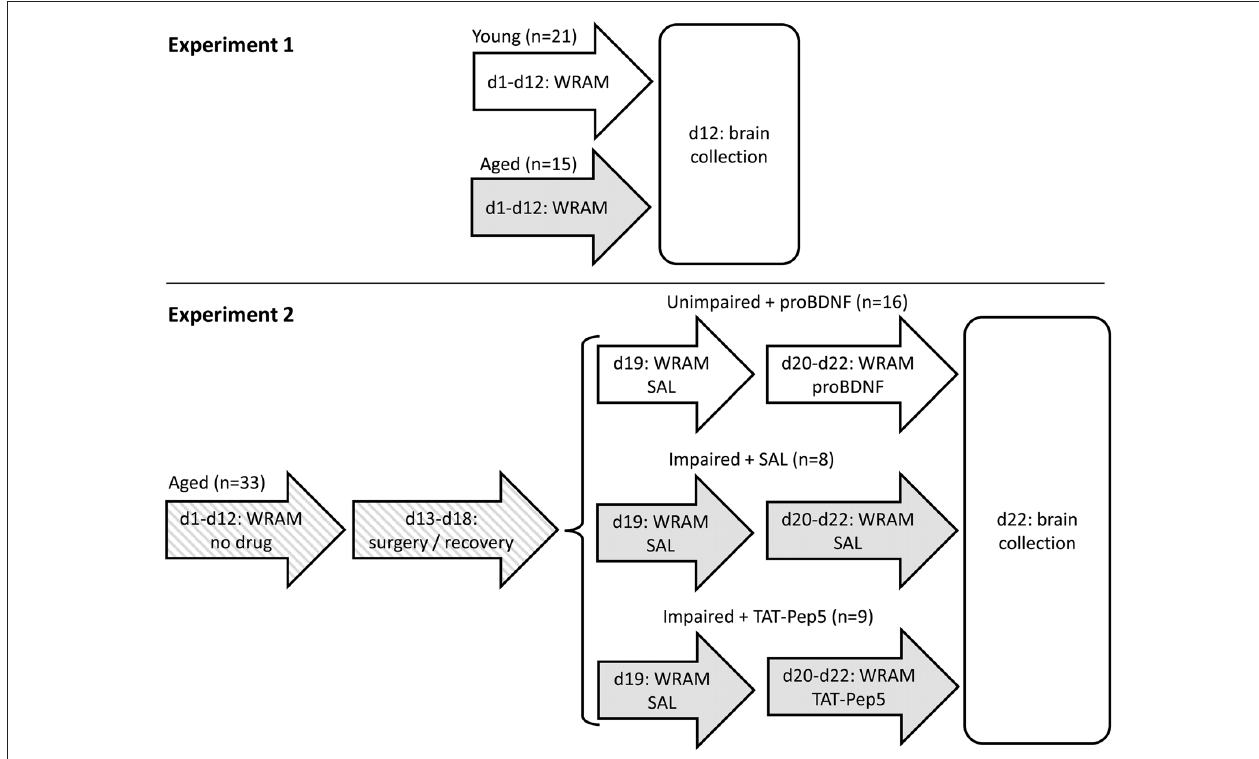
FIGURE 1 | Timeline of Experiments 1 and 2. In Experiment 2, mice were split into three groups based on their performance (unimpaired/impaired) and henceforth infused with different drugs (saline, proBDNF, TAT-Pep5). d, day of study; WRAM, behavioral training/testing in the water radial arm maze task; SAL, saline.